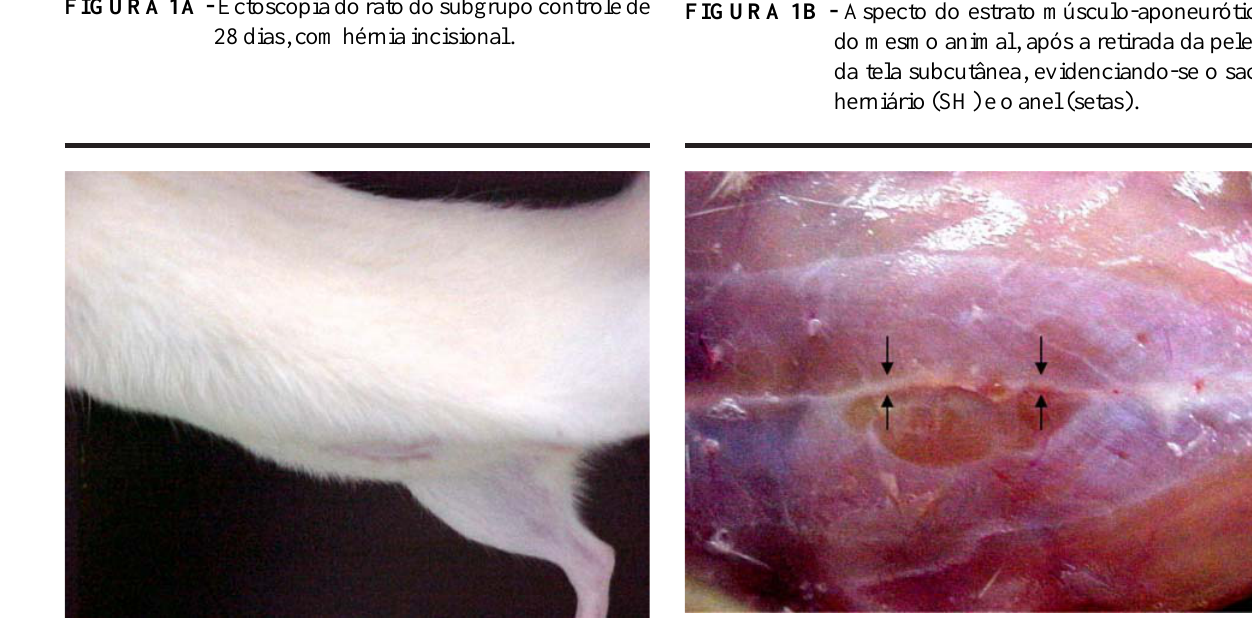
FIGURA 2B - Aspecto do estrato músculo-aponeurótico do mesmo animal, após a retirada da pele e da tela subcutânea, evidenciando-se a cicatriz na linha alba